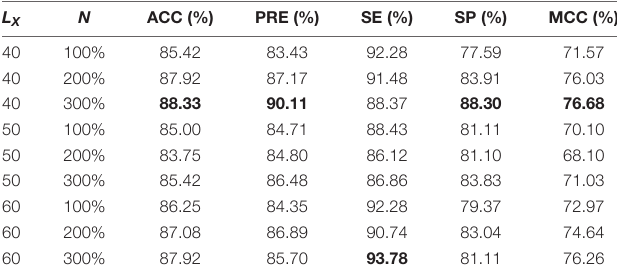
TABLE 2 | Performance of ACP-DA with different parameters based on ACP240 (The best metrics are in